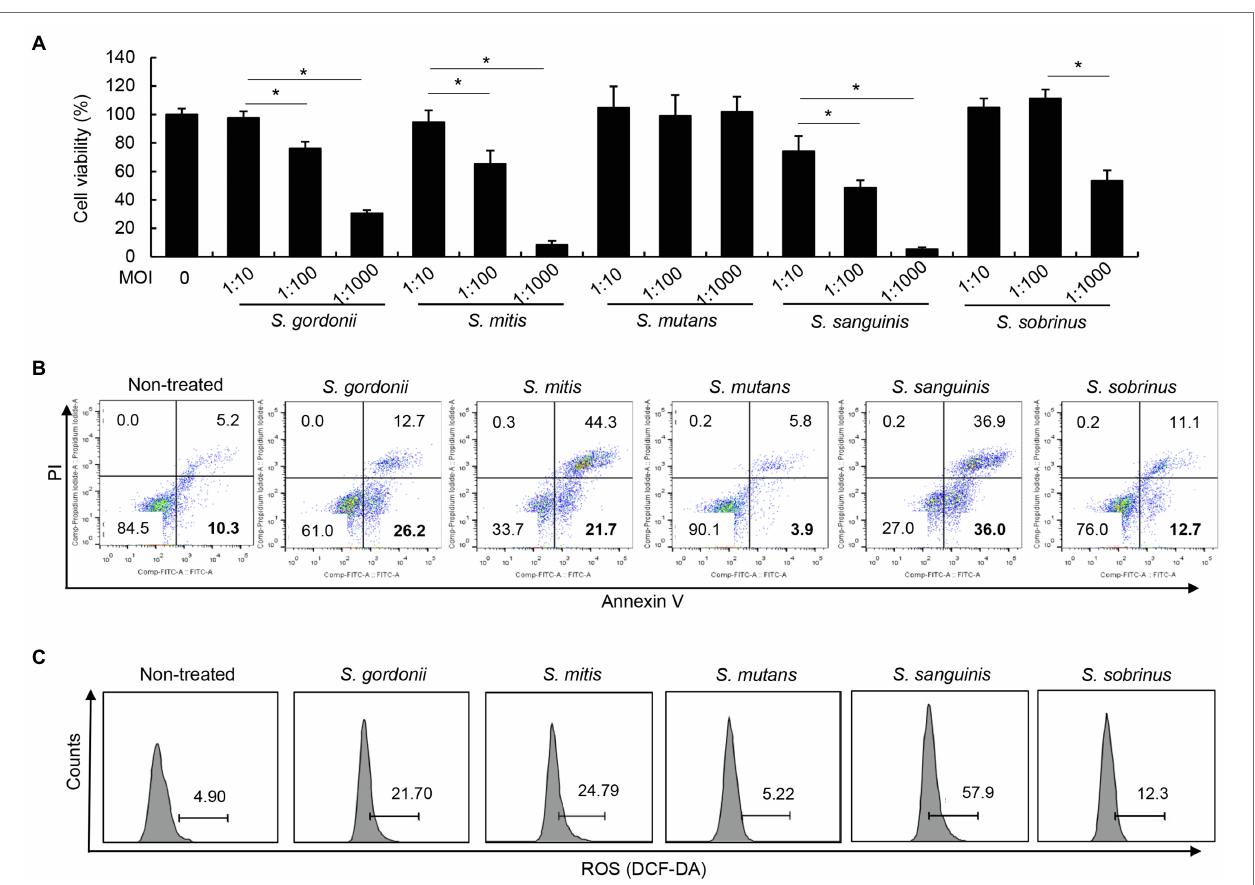
FIGURE 4 | Various streptococcal species differ in induction of apoptosis and ROS in human PDL cells. (A) PDL cells were treated with S. gordonii , S. mitis , S. mutans , S. sanguinis , and S. sobrinus at MOI 1:10, 1:100, or 1:1,000 for 3 h. Trypan blue assay was used to determine the number of viable cells. (B) PDL cells were treated with S. gordonii , S. mitis , S. mutans , S. sanguinis , and S. sobrinus at MOI 1:1,000 for 1 h. The cells were strained with annexin V and PI and then analyzed using flow cytometry. (C) PDL cells were treated with 10 μ M of DCF-DA for 30 min at 37 ° C. The DCF-DA-treated cells were washed with PBS and then treated with S. gordonii , S. mitis , S. mutans , S. sanguinis , and S. sobrinus at MOI 1:1,000 for 3 h in a CO 2 incubator. Fluorescent intensity was analyzed by flow cytometry. One of three similar results is shown. * p <